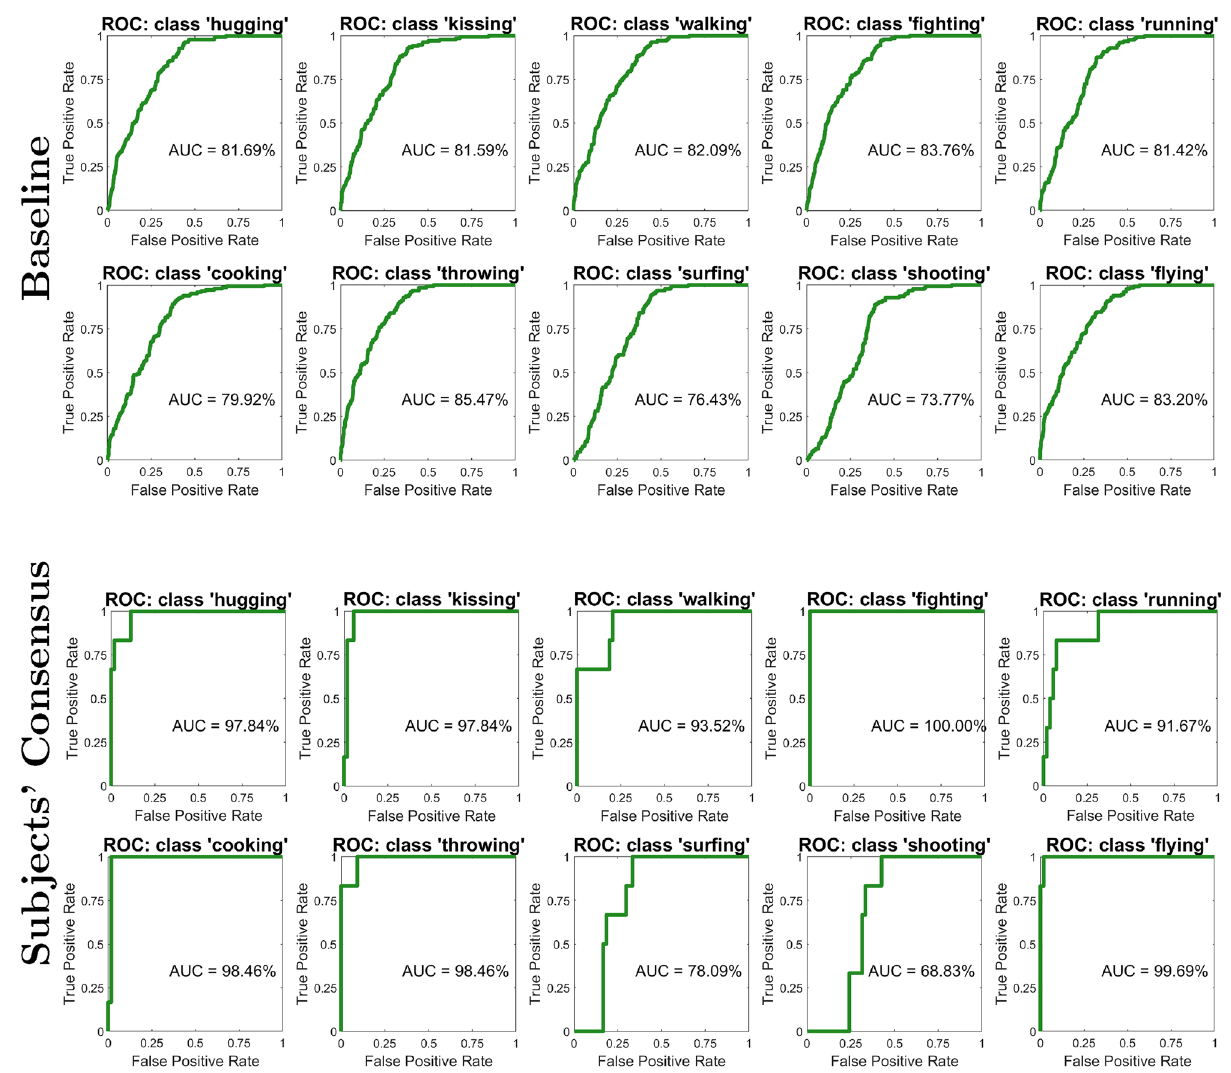
Figure 4. The effect of subject consensus on EEG data. Receiver Operating Characteristic (ROC) curve related to the softmax scores of the multi-layer perceptron (MLP) trained with differential entropy (DE) features. We directly compare the performance, in EEG classification, of the model without model consensus ( top panel ) with the regularizing effect of subjects consensus ( bottom panel ) which improves the action recognition for the video